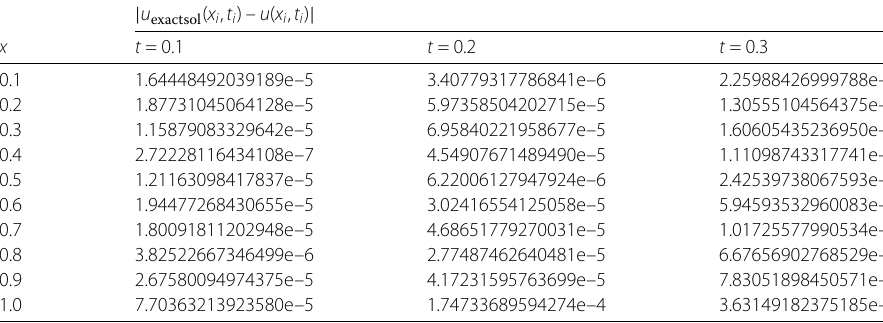
Table 5 Comparison of maximum absolute errors acquired using the GWGM for β = 1/2, α = 1 of Example 2 with given initial and boundary conditions